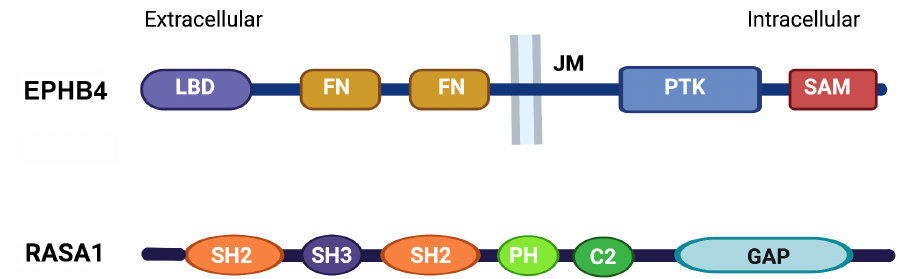
Figure 1. Domain structure of EPHB4 and RASA1. LBD, ligand-binding domain; FN, Fibronectin homology; JM, juxtamembrane region; PTK, protein tyrosine kinase domain; SAM, sterile alpha motif domain; SH2 and SH3, Src homology-2 and 3 domains; PH, pleckstrin homology domain; C2, protein kinase C2 homology domain; GAP, RasGTPase-activating domain.